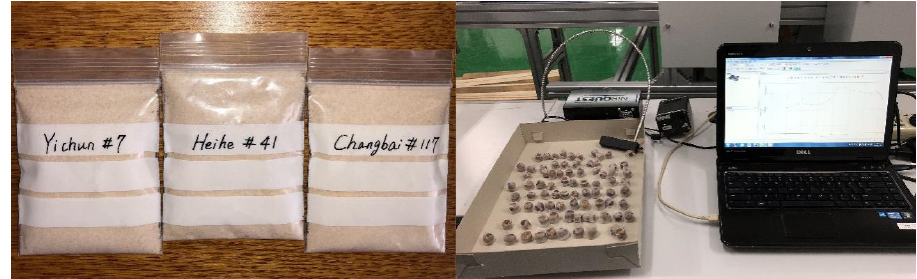
Figure 1. Pine nut samples and surface scan using the NIRQuest512 spectrometer.